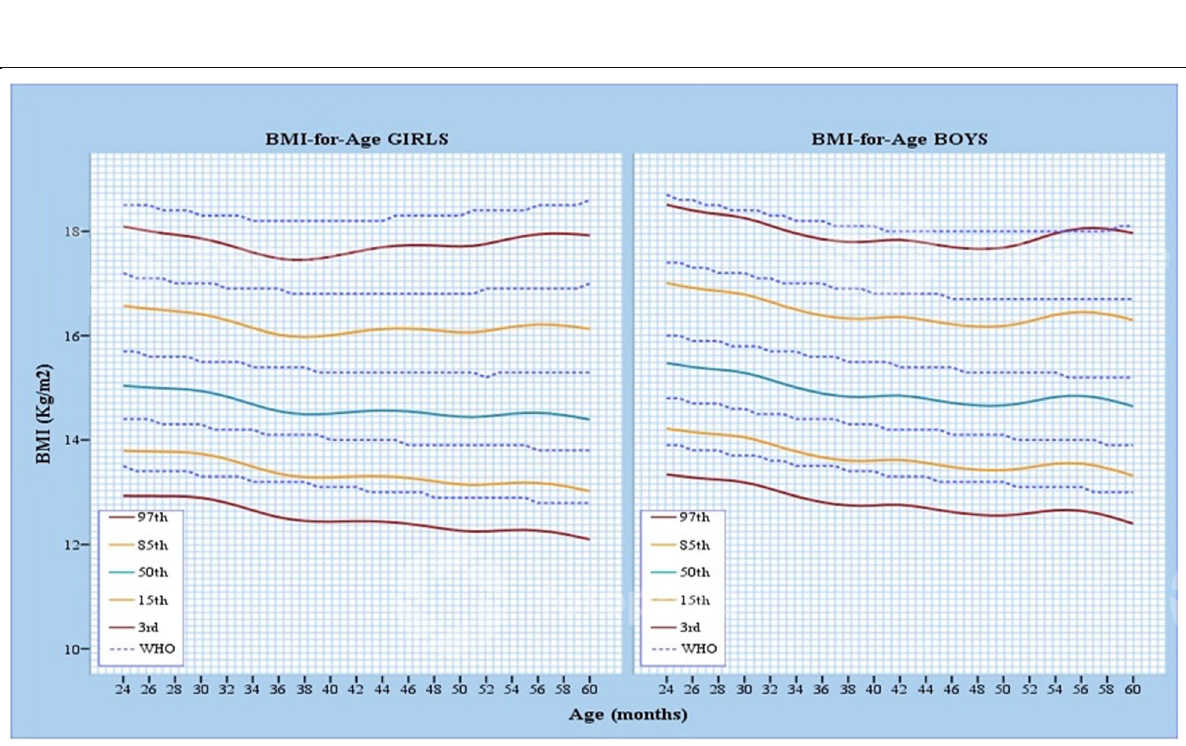
Fig. 3 BMI percentiles (P3, P15, P50, P85, and P97) by age for girls and boys ages 2 – 5 years who were born in Isfahan compared to the WHO growth